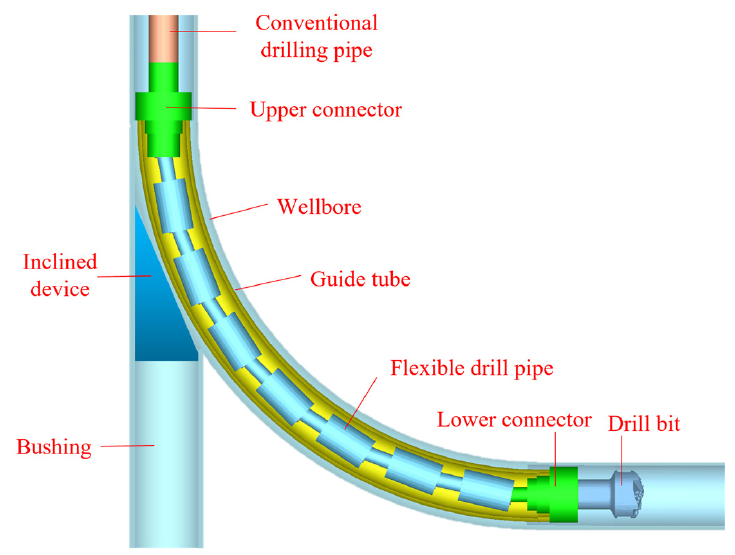
Figure 1. Schematic diagram of ultra-short-radius flexible drilling tool.